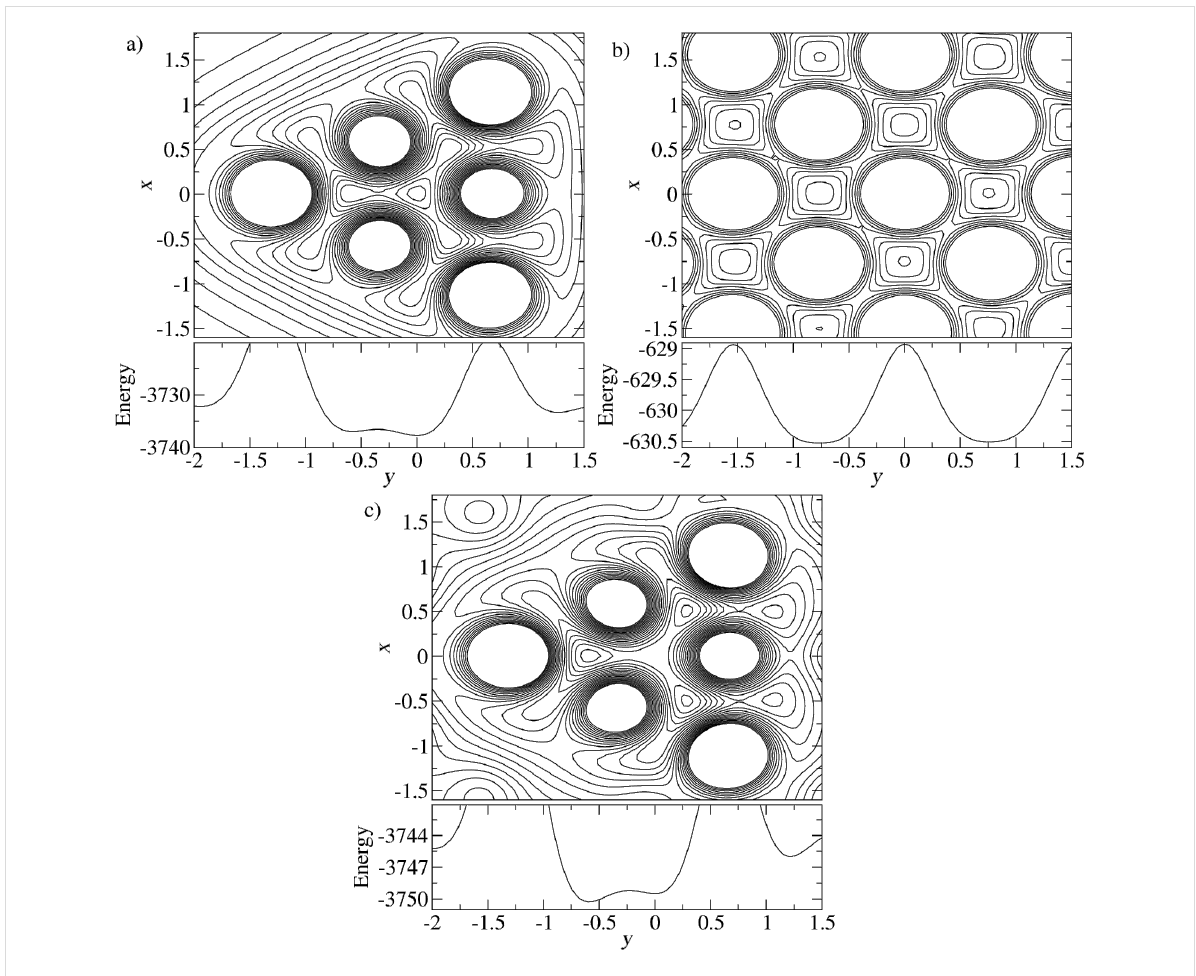
Figure 6: Potential energy surface a) in the (111)-plane of the apex atom, when the tip is far away from the substrate; b) for an adatom in a plane above the substrate; c) in the (111)-plane of the apex atom when the tip is near the substrate ( d = 1.05). The graphs under the contour plots show the corresponding cross-section of the potential energy surface for x =